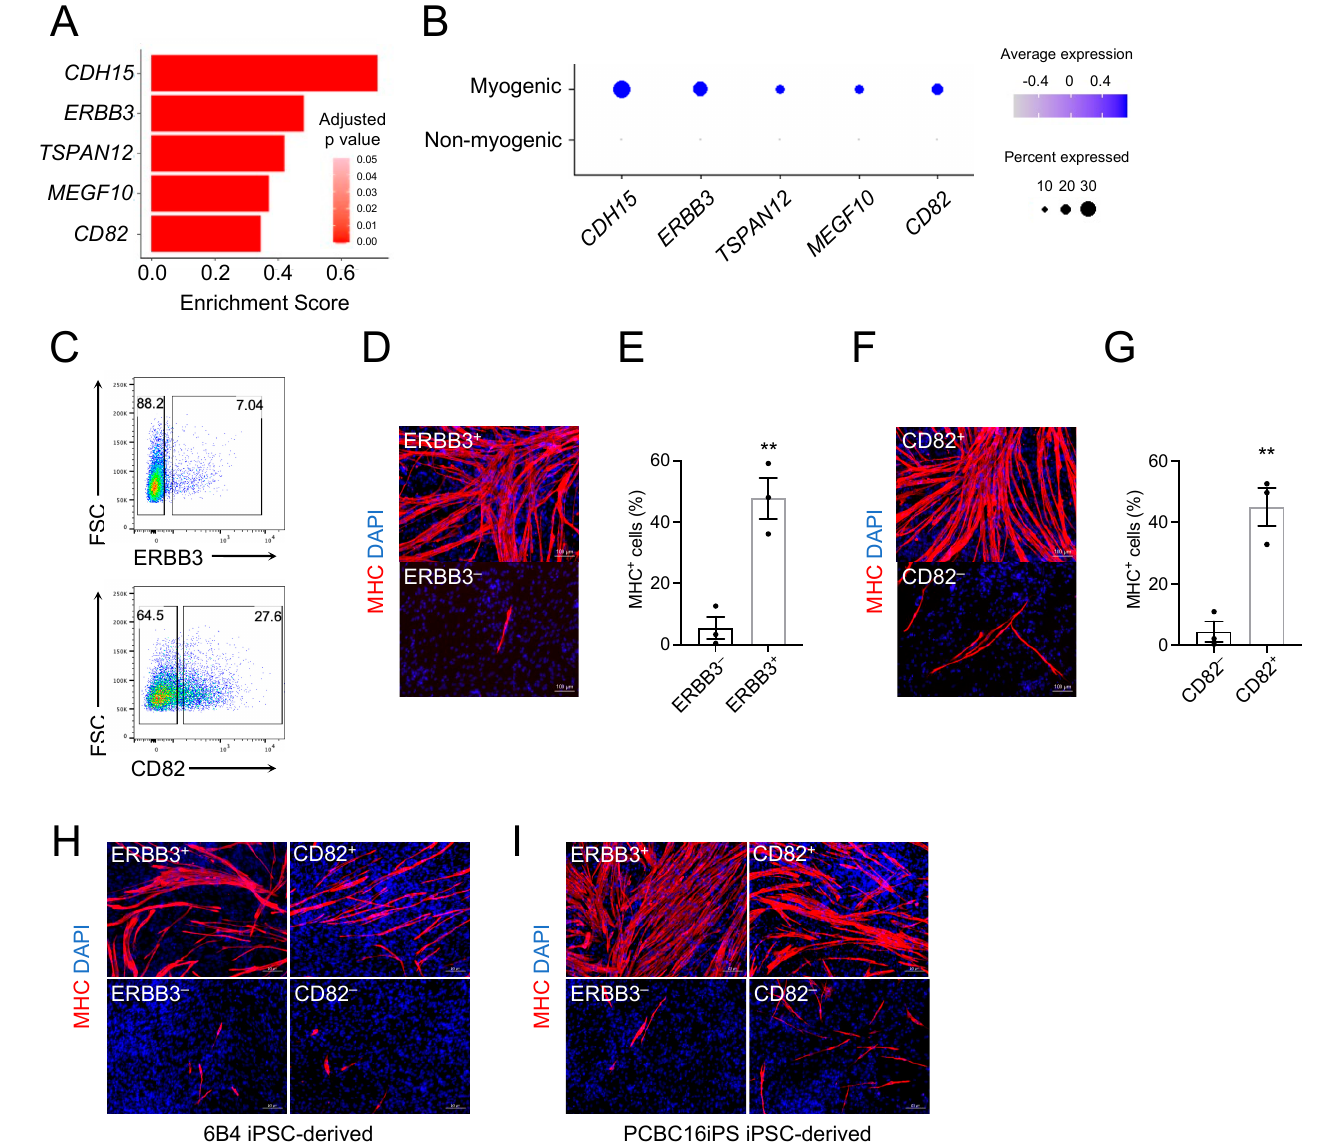
Figure 4. ERBB3 and CD82 are prospective surface markers for isolating skeletal myogenic progen- itors from human PSC-derived teratomas. ( A ) Gene expression of candidate surface markers for skeletal myogenic cells. Expression is shown as a log-fold change in expression in skeletal myogenic clusters relative to the non-myogenic population. ( B ) Dot plot showing the enrichment of candidate surface markers in the skeletal myogenic population. ( C ) Representative FACS profiling of H1 ESC- derived teratoma cells using ERBB3 (top) and CD82 (bottom) antibodies. ( D ) Immunostaining and ( E ) quantification from three independent experiments of MHC in ERBB3 + and ERBB3 – cell fractions cultured in differentiation medium showing MHC + myotubes are mostly found in the ERBB3 + cell fraction. Scale bar represents 100 μ m. ** p < 0.01. Data are shown as mean ± SEM. ( F ) Immunostain- ing and ( G ) quantification from three independent experiments of MHC in CD82 + and CD82 – cell fractions cultured in differentiation medium showing MHC + myotubes are mostly found in the CD82 + cell fraction. Scale bar represents 100 μ m. ** p < 0.01. Data are shown as mean ± SEM. ( H , I ) ERBB3 + and CD82 + cells isolated from ( H ) 6B4 human iPSC-derived and ( I ) PCBC16iPS human iPSC- derived teratomas differentiate into MHC + myotubes. Representative images from three independ- ent teratomas are shown. Scale bar represents 100 μ m.